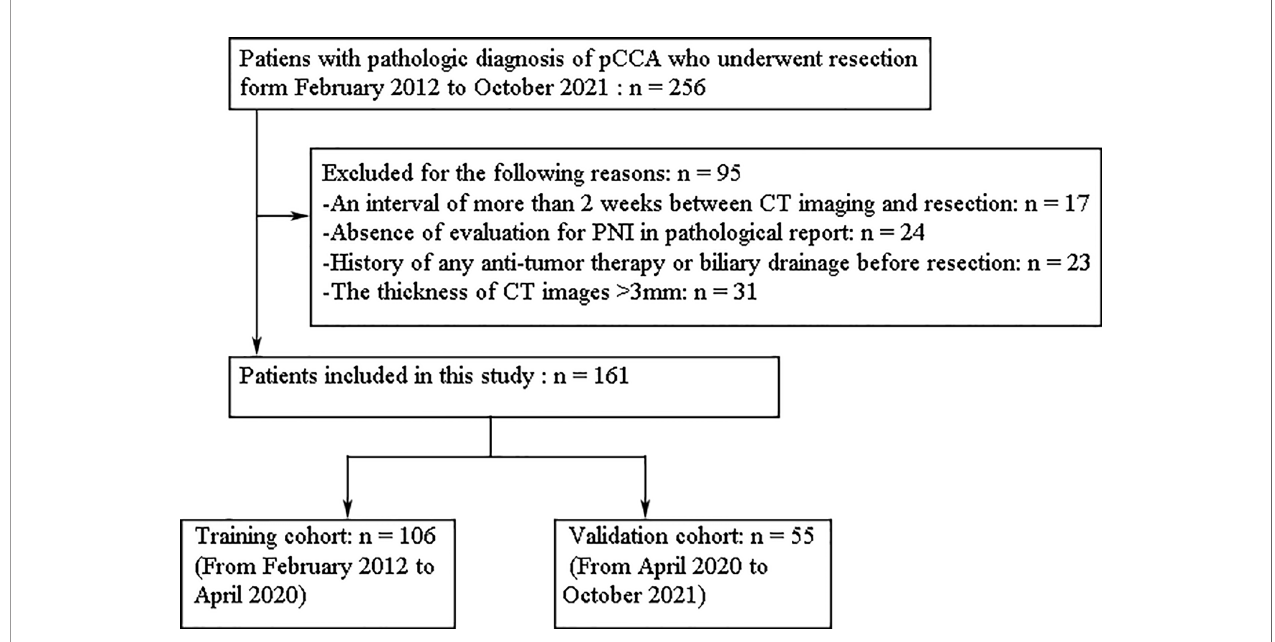
FIGURE 1 | The fl owchart of patient selection in this